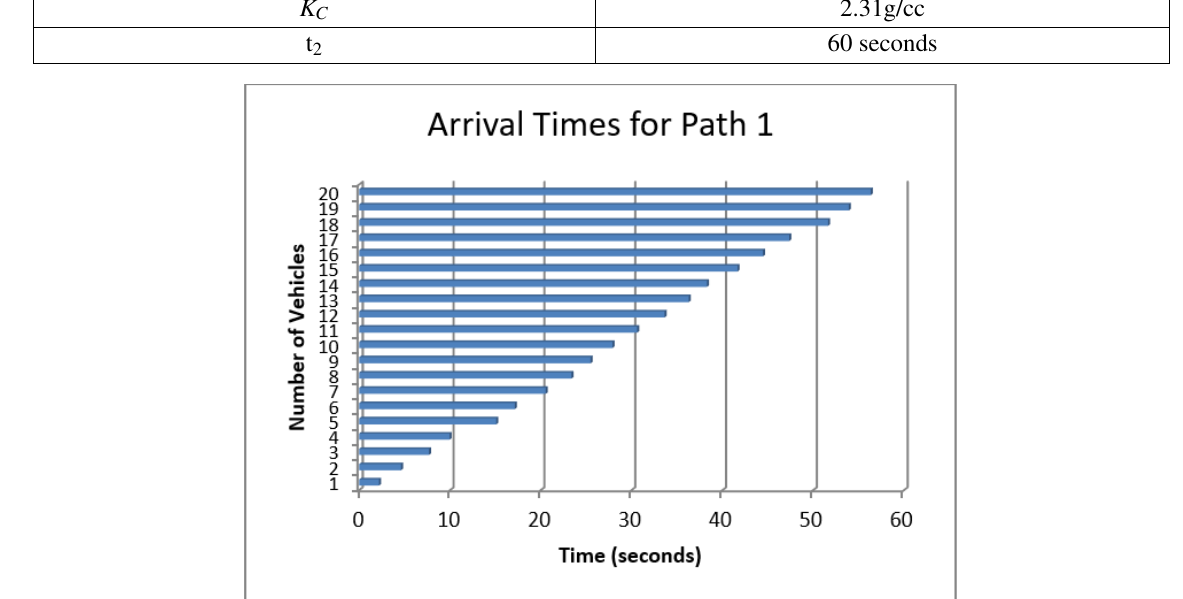
Figure 4. Arrival Time for each vehicle